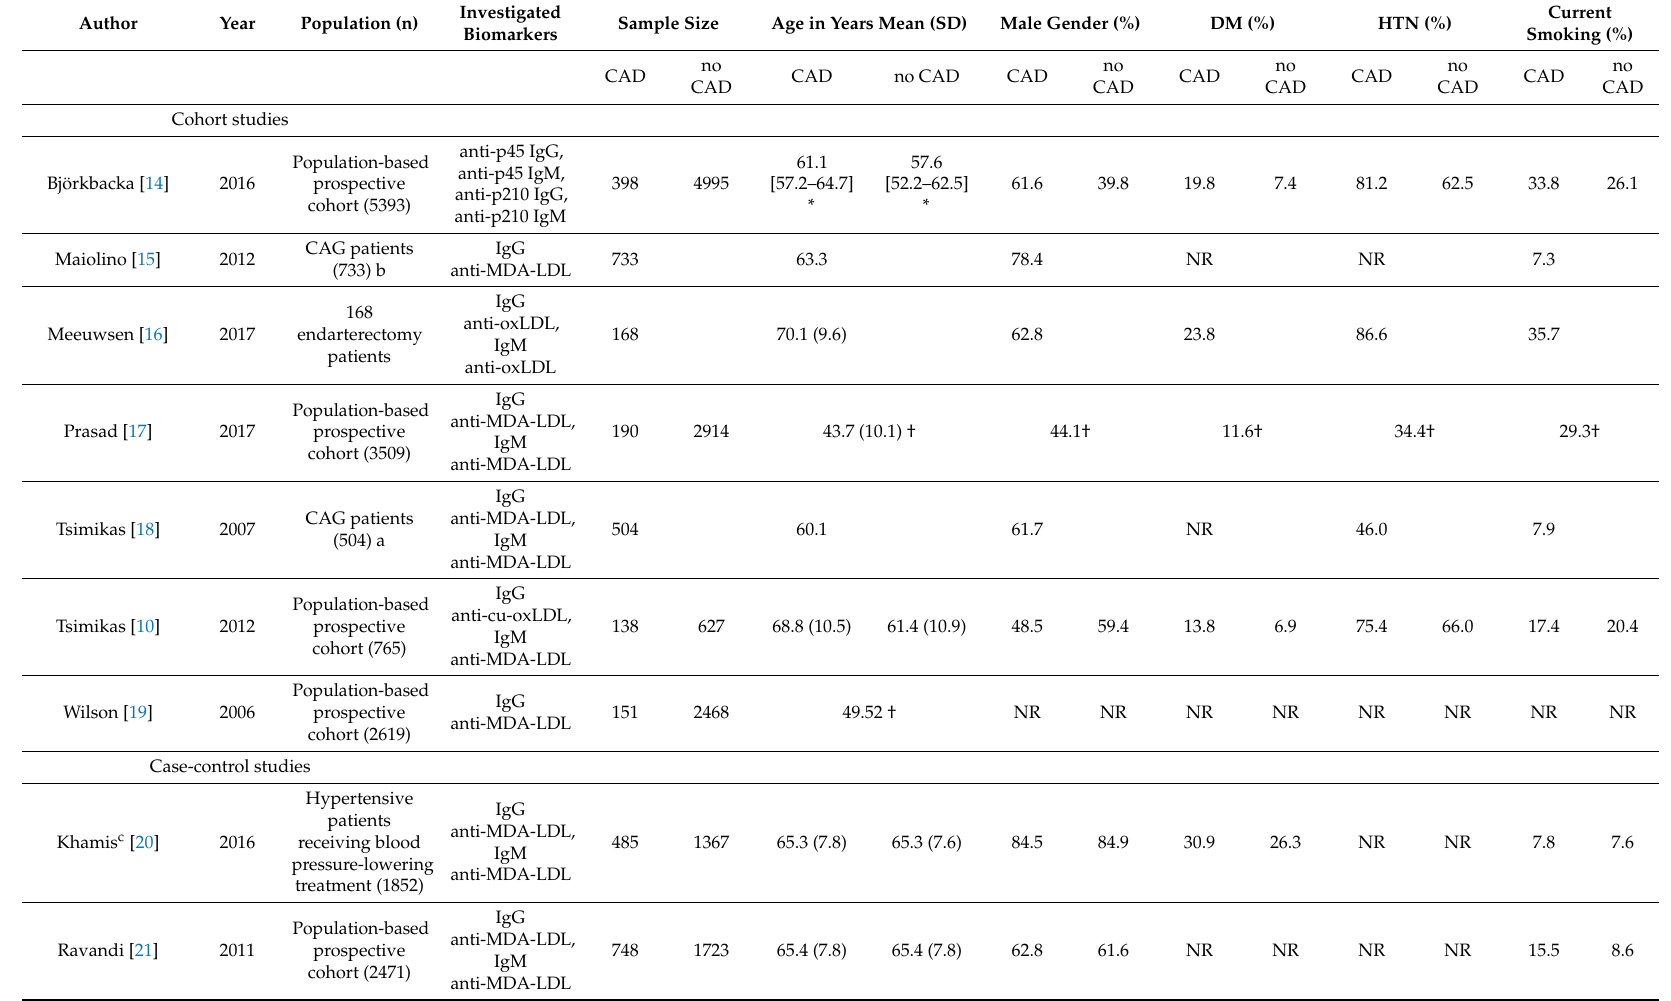
Table 1. Baseline characteristics of the included